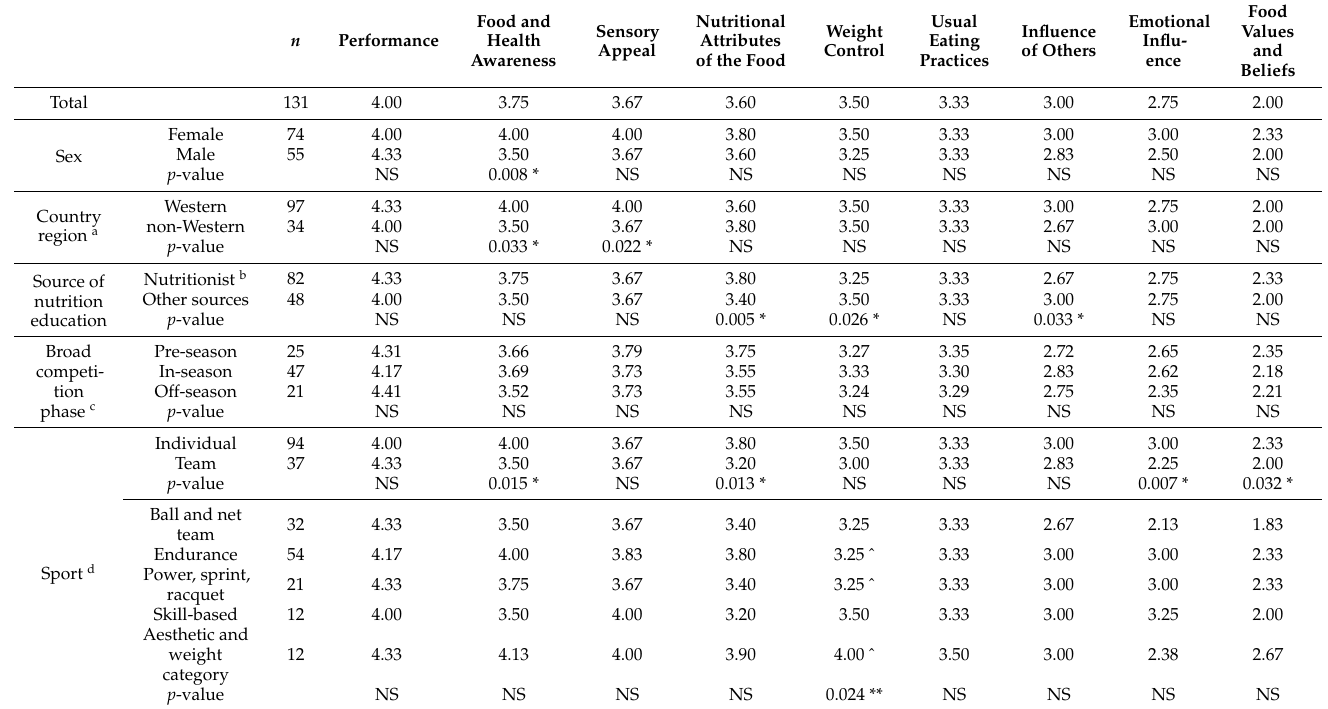
Table 3. Median score for the AFCQ factors based on athlete sex, country region, sport, broad competition phase, and nutrition education ( n =